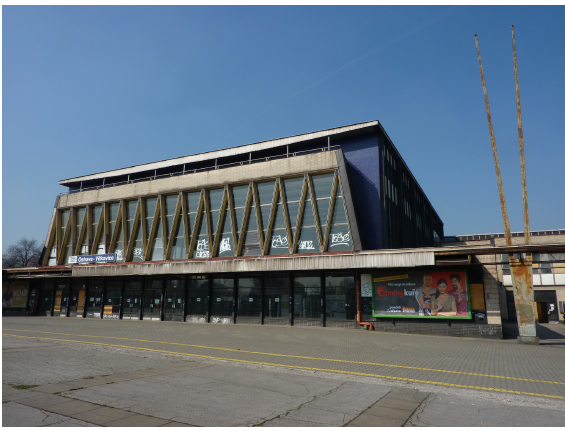
Figure 1. Ostrava-Vítkovice railway station.